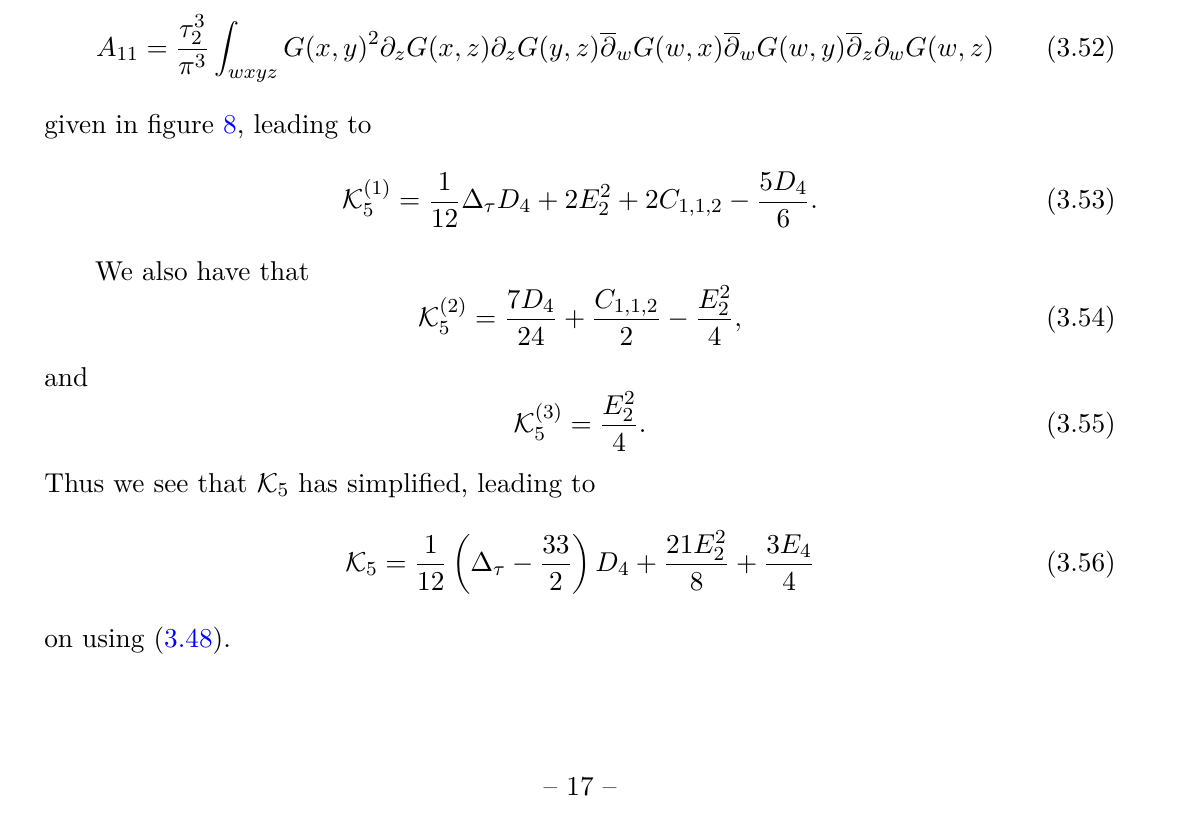
( v ) , (iii) π 2 K (3) 5